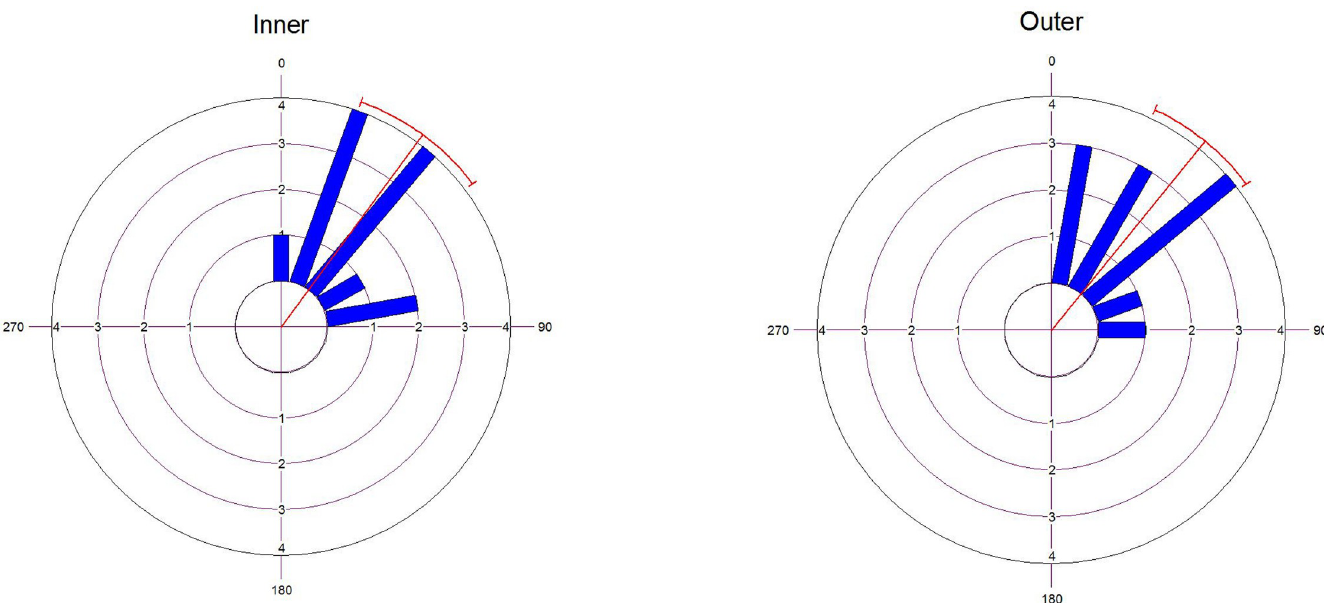
Fig 5. Angular orientation of the axis of maximum stiffness for both cortical plates in the baboon´s skull. The direction 0 matches the direction of the sagittal suture.